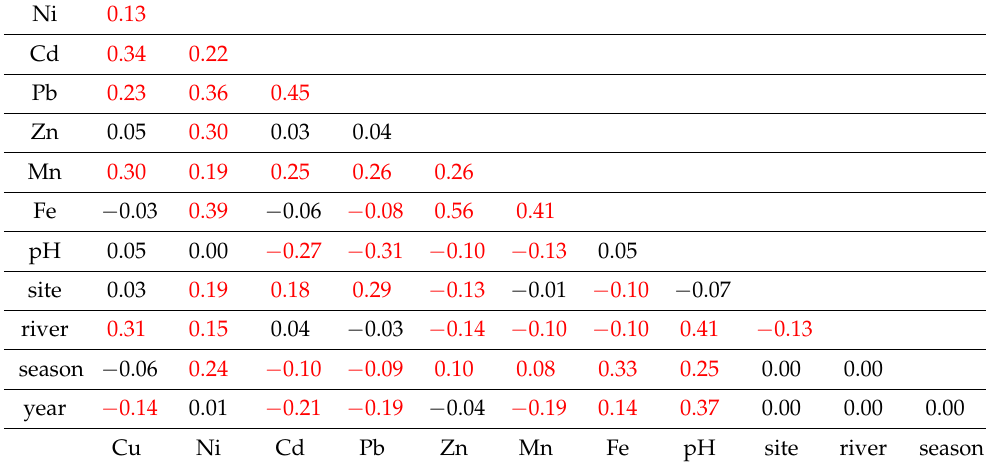
Figure 12. Ordination of the 29 study sites by PCCA based on concentrations of elements in plants and water (pH) in all investigated rivers. Table 10. Spearman’s correlation of metal content in reed canary grass and water reaction, study site, season and year. Differences statistically significant at p ≤ 0.05 marked with red.